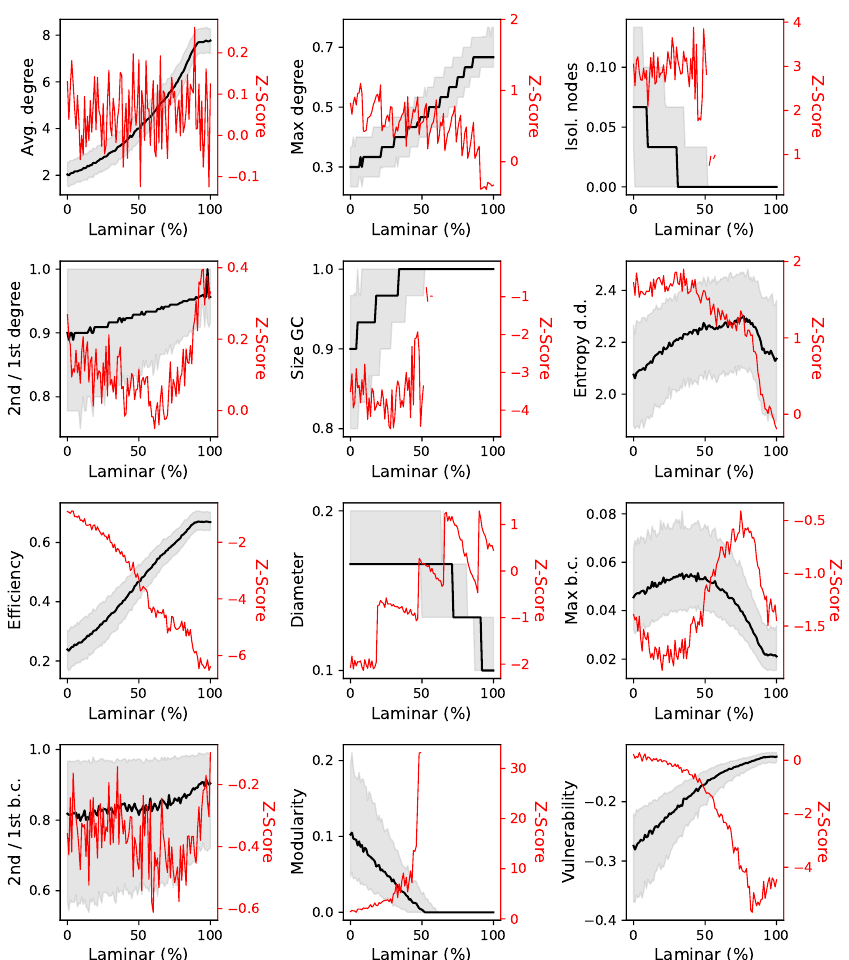
Figure A4. Evolution of the topological metrics yielded by the synthetic model, in the laminar condition, as a function of the laminar constraint λ . Black (left Y axes) and red lines (right Y axes), respectively, correspond to the raw values of the metrics and their Z-Scores. Grey bands correspond to the 10–90 percentiles.